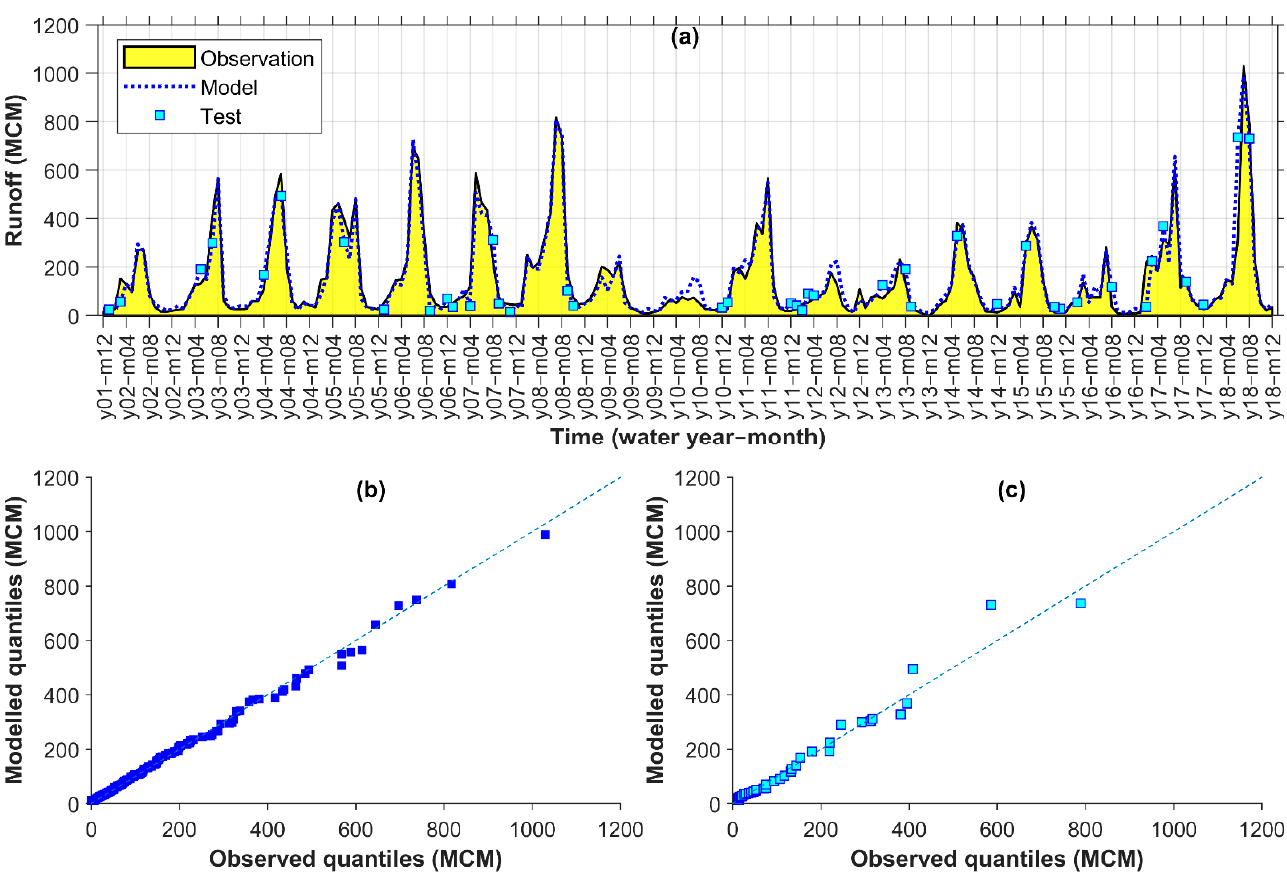
Figure 6. Seymareh observed vs. modelled monthly runoff time series ( a ) and q–q plots for calibration ( b ) and test ( c ) points (MCM: million cubic meters). Table 7. Performance criteria values for the selected (Comb. 7 Lag 0–2) vs. reference model (Comb. 5 Lag 0–2) in testing points for Seymareh (RMSE and MAE are in million cubic meters while the others are unitless) and the change rate (%) between them.